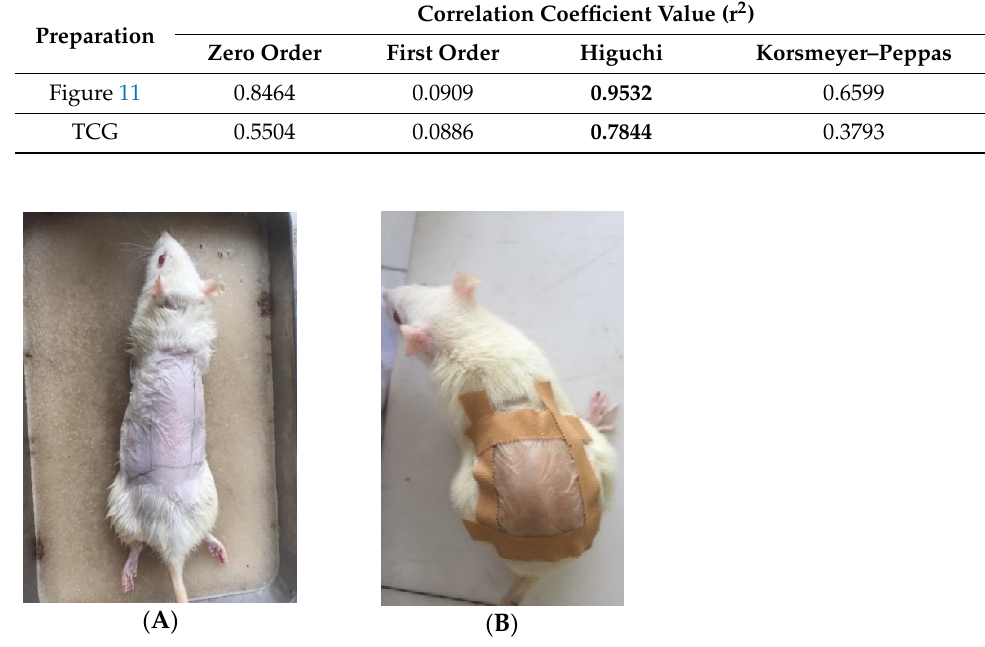
Figure 11. Visualization of experimental animal treatment ( A ) Before gel application, ( B ). During gel application.